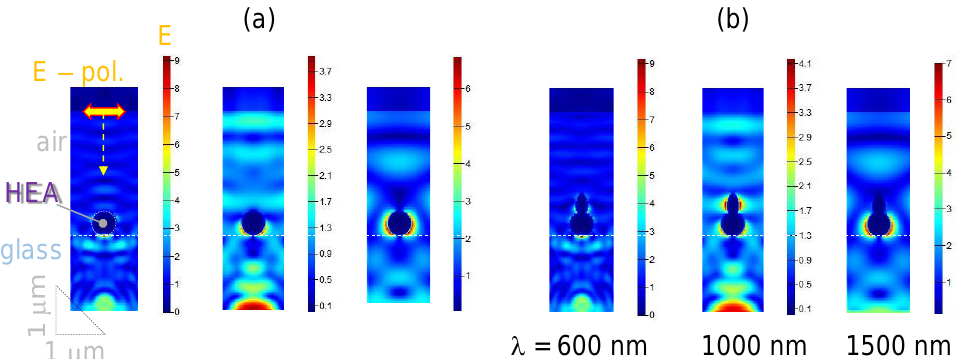
Figure A2. Light field enhancement by a HEA microparticle (on glass) at different wavelengths calcu- lated by FDTD for spherical ( a ) and snowman ( b ) structures as observed in experiments (Figure 3b; incident E-field is | E | = 1. HEA is modeled as homogeneous refractive index ( n + i κ ) of HEA (Figure 2b). Boundary conditions: perfect matching